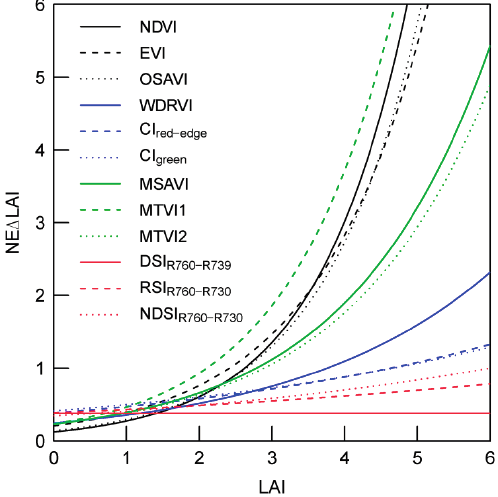
Figure 4. Sensitivity (NE Δ LAI) of the SIs tested in the